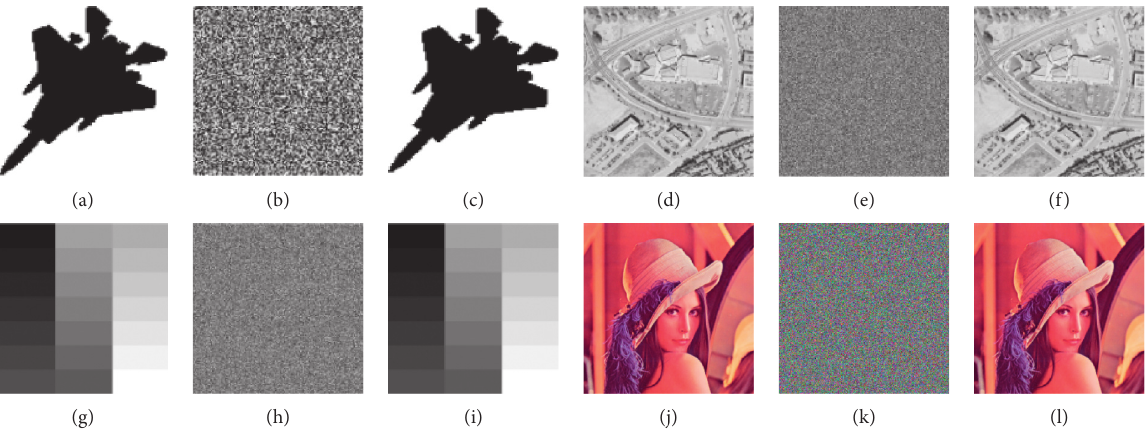
Figure 7: Encryption and decryption effects for different types of images: (a) f15.png; (b) cipher image of (a); (c) decrypted image of (b); (d) 5.2.09.tiff; (e) cipher image of (d); (f) decrypted image of (e); (g) gray21.512.tiff; (h) cipher image of (g); (i) decrypted image of (h); (j) 4.2.04.tiff; (k) cipher image of (j); (l) decrypted image of (k); (m) f15.png; (n) cipher image of (m); (o) decrypted image of (n); (p) f15.png; (q) cipher image of (p); (r) decrypted image of (q); (s) f15.png; (t) cipher image of (s); (u) decrypted image of (t); (v) f15.png; (w) cipher image of (v); (x) decrypted image of